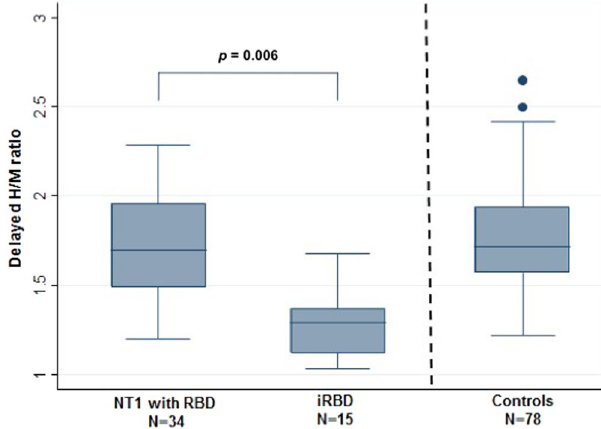
Figure 1. Delayed heart-to-mediastinum (H/M) ratio in patients with narcolepsy type 1 (NT1) with rapid eye movement sleep behavior disorder (RBD), in patients with idiopathic RBD (iRBD) and in controls. Results are shown as box-whisker plots with the median and 25th quartile of the delayed H/M